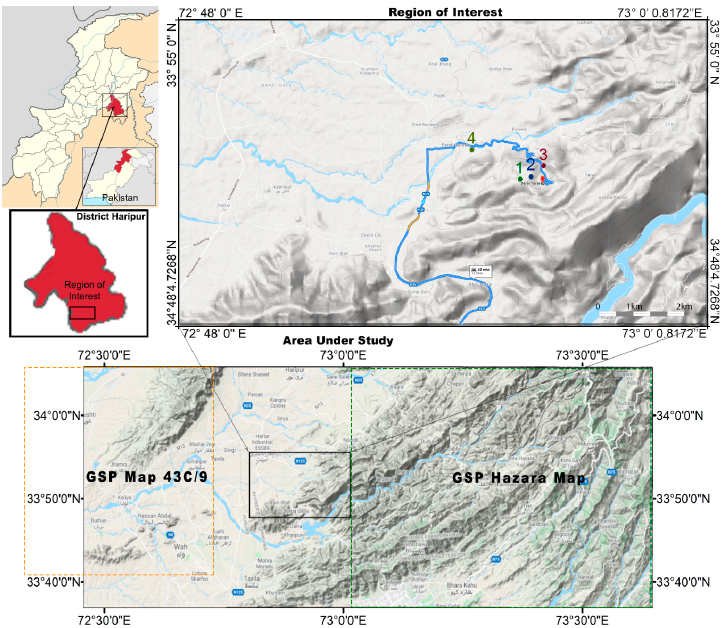
Figure 1. The area under study with the locations of GSP maps and the region of interest where maps were not available. The blue line in the region of interest represents the traverse route taken to validate the classification results while Pt. 1: (72.94397E, 33.8592N), Pt. 2: (72.946938E, 33.860744N), Pt. 3: (72.95020E, 33.863123N), and Pt. 4: (72.9277E, 33.86615N) markers show the locations of field pictures.